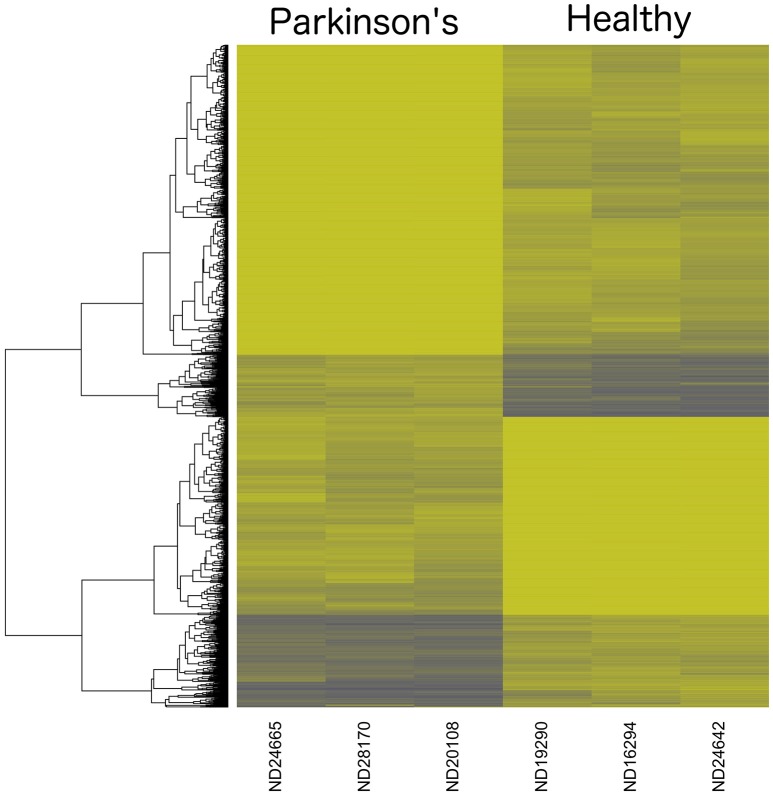
Dendrogram Heatmap of CpGs: p < 0.0025. Focusing on the most statistically significant CpG site changes, there are 1008 CpG sites with a methylation score difference with a probability of a type-I error of p < 0.0025 (after applying a false-discovery rate adjustment). The resolution between Parkinson's Disease patients and healthy males reveals quantitative separation among these groups of CpG sites. Each row represents the score values for a single CpG[i] site, with a hierarchical clustering association based on % methylation across all six individual samples in the study.